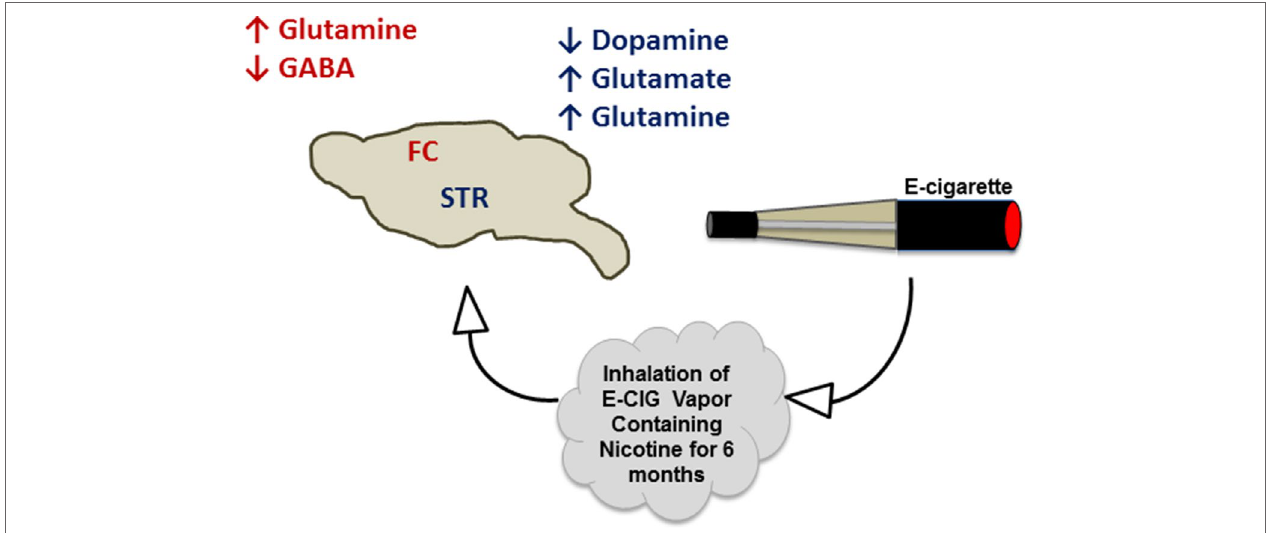
( Figure 6 ). The changes in neurotransmitter levels in